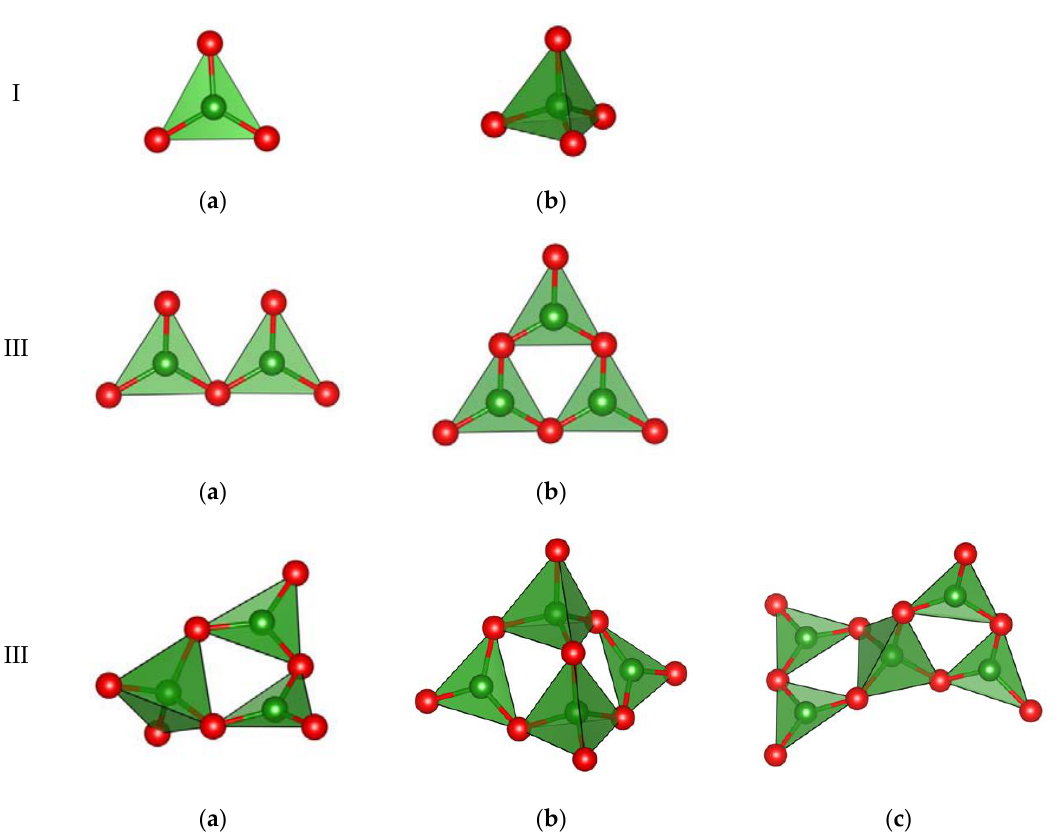
Figure 1. Examples of “building units” for anions and polyanions in anhydrous borates: ( I ) isolated fundamental units, only in orthoborates ( a ), ( b ); ( II ) island clusters, in pyroborates ( a ) and metaborates ( b ); ( III ) combined basic structural units in highly condensed polyanions ( a ), ( b ), ( c ). The green and red balls represent B, and O atoms, respectively.